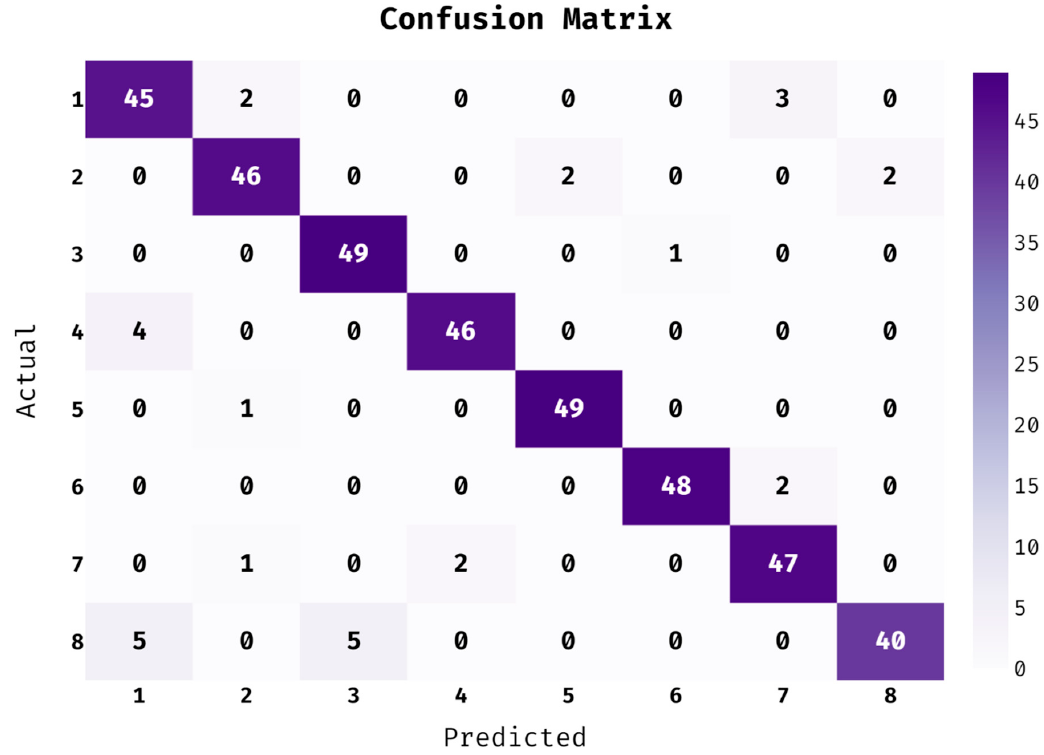
Figure 5. Confusion matrix of CIWHO-ORC technique on Traffic light dataset.